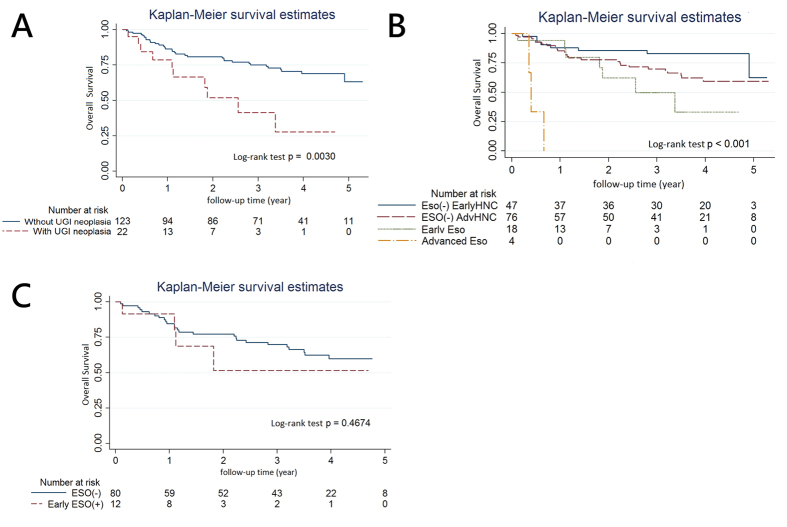
(A) Survival of head and neck squamous cell carcinoma (HNSCC) patients with synchronous upper gastrointestinal (UGI) tract neoplasia versus those without lesions. (B) Survival estimates according to staging of primary tumors and existence of synchronous esophageal neoplasia. (C) Survival estimates of advanced (stage III&IV) HNSCC patients with early esophageal neoplasia (stage 0~II) and those without lesions.